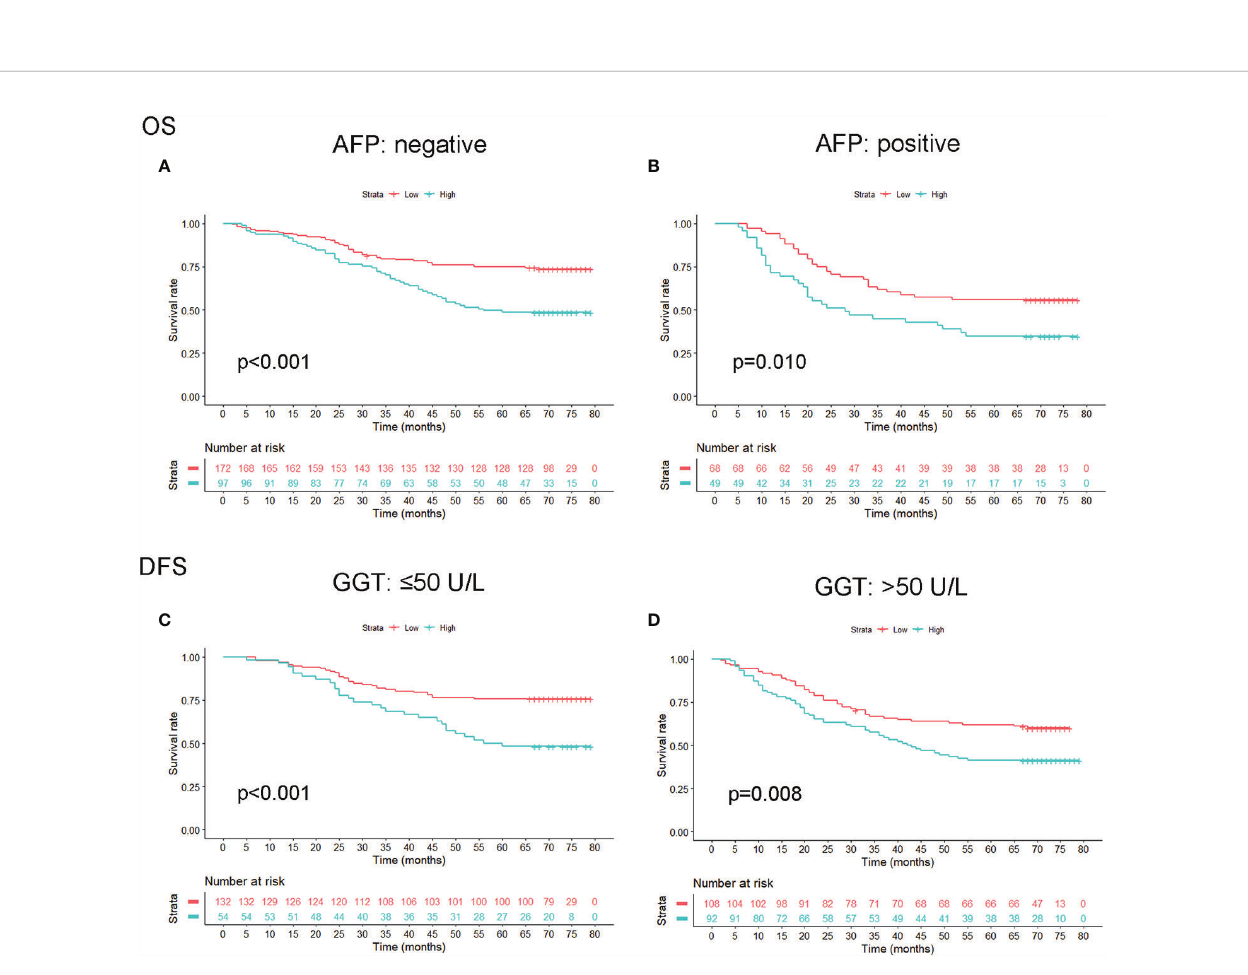
Frontiers in Oncology |